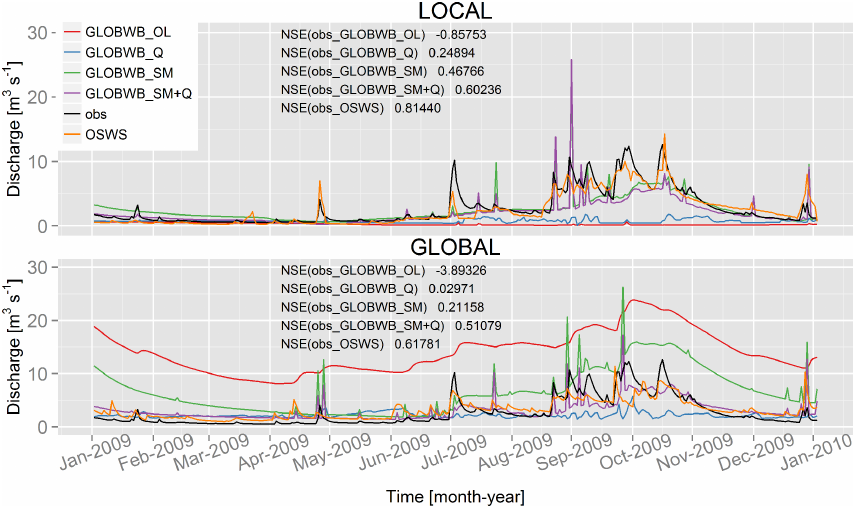
Figure 8. Simulated and observed streamflow estimates at gauging station no. 410088 in a tributary of the Murrumbidgee River for the time period January 2009–January 2010. The upper panel shows streamflow when local data are used as model forcing. Streamflow obtained with the global forced models is shown in the lower panel. Each panel contains results for each data assimilation scenario and the observed streamflow estimates plotted with different coloured lines (OSWS – orange, GLOBWB_OL – red, GLOBWB_Q – blue, GLOBWB_SM – green, GLOBWB_SM + Q – purple and obs – black). The ensemble mean is given for each data assimilation